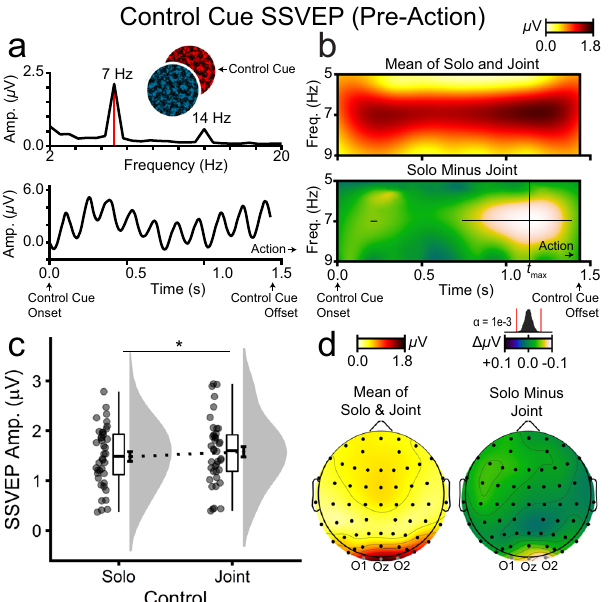
Fig. 6 Neural activity elicited by the action control cue prior to the onset of solo and joint actions ( n = 40 participants). The action control cue (coloured green or red) indicated whether participants were to undertake a solo or joint control action upon onset of the action cue. Depicted data correspond to the pre-action trial period beginning with control cue onset and ending with control cue offset. a Grand mean FFT and ERP to the action control cue. The action control cue SSVEP is visible as a 7 Hz frequency- domain spike (FFT, upper panel) and time-domain oscillatory activity (ERP, lower panel). b Wavelet time-frequency heat maps. In the lower panel, the histogram on the bottom re fl ects a permutation simulation distribution with red lines indicating signi fi cance thresholds. The superimposed black lines in the lower panel indicate time points at which SSVEP amplitudes were signi fi cantly higher for joint compared with solo control actions. c Morlet wavelet SSVEP amplitudes at the time point of maximal deviation between solo and joint control ( t max ), assessed via wavelet analysis. d Wavelet SSVEP amplitude topographies at t max, revealing focused activity over occipital electrodes (O1, Oz, O2). Note that panels b (lower) and d share the same colour scale and limits.